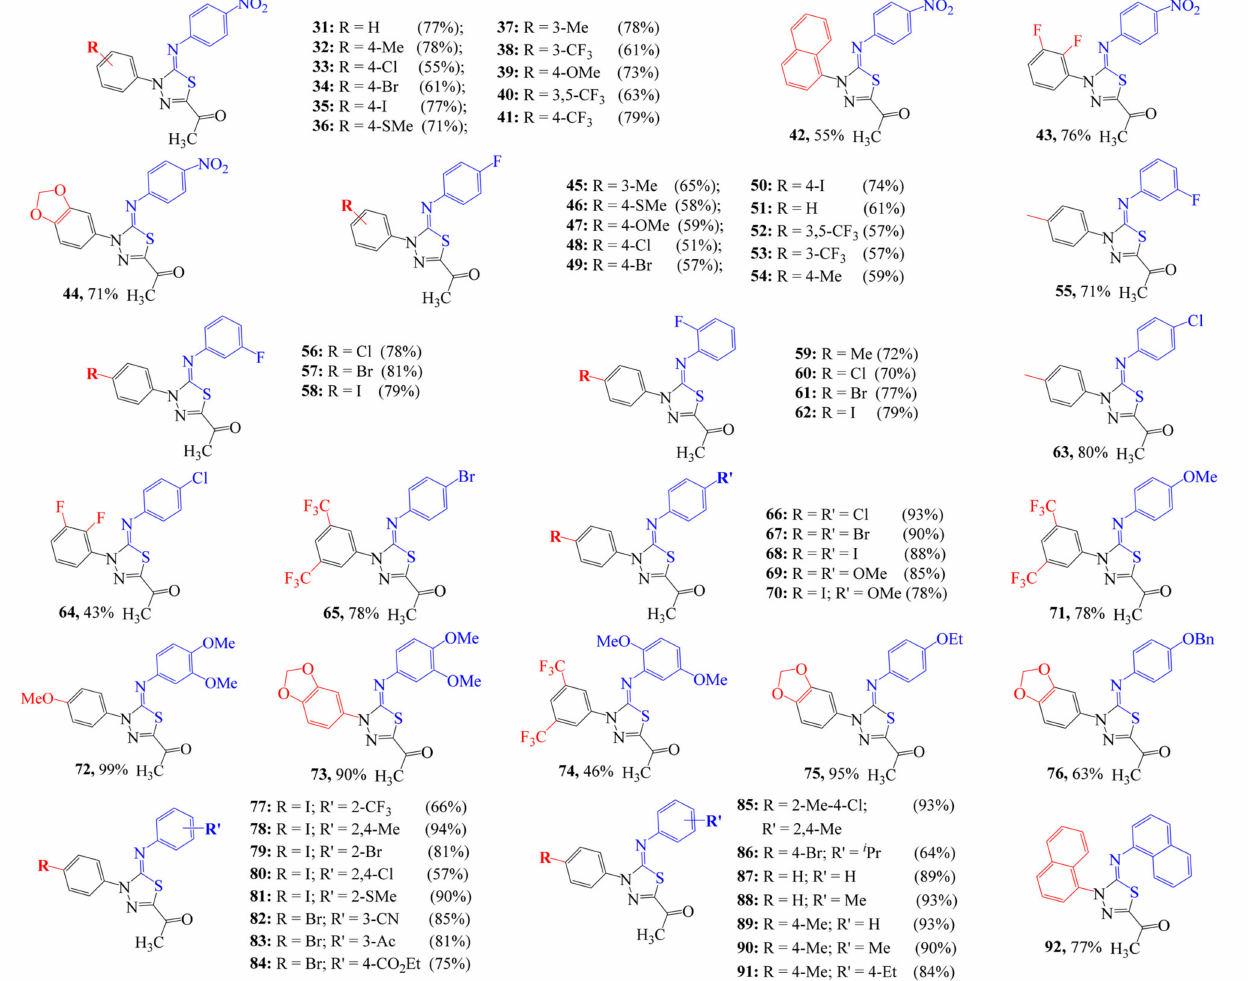
Figure 4. Preparation of variously substituted 1,3,4-thiadiazole derivatives 31 – 92